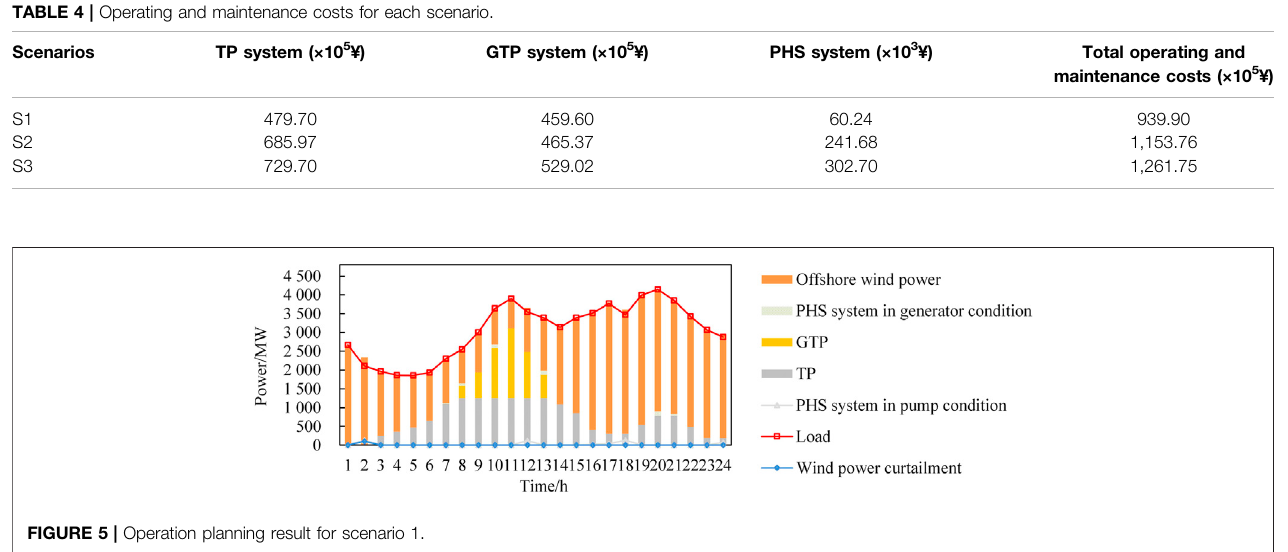
FIGURE 5 | Operation planning result for scenario 1.